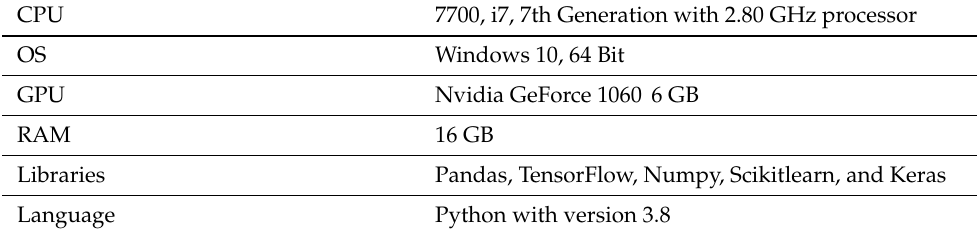
Table 4. Experimental